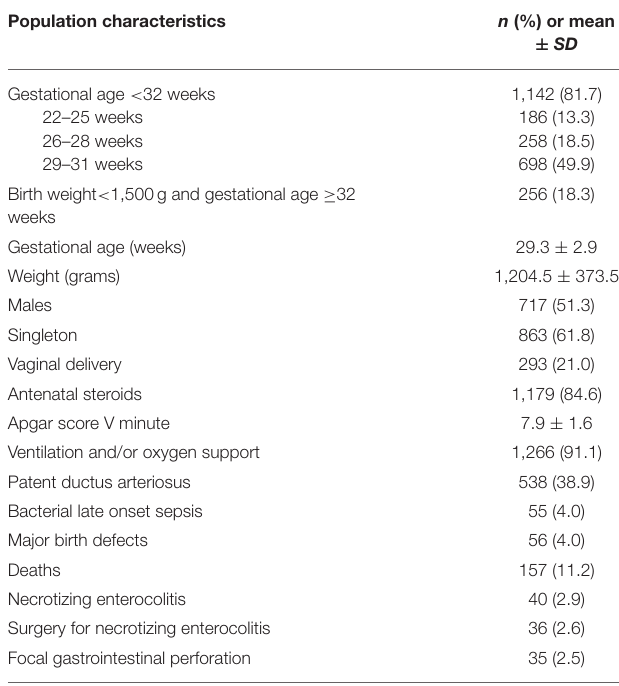
TABLE 1 | Principal characteristics of the 1,398 newborn infants < 32 weeks gestation or < 1,500g included in the registry from 1-01-2012 to 31-12-2015. Population